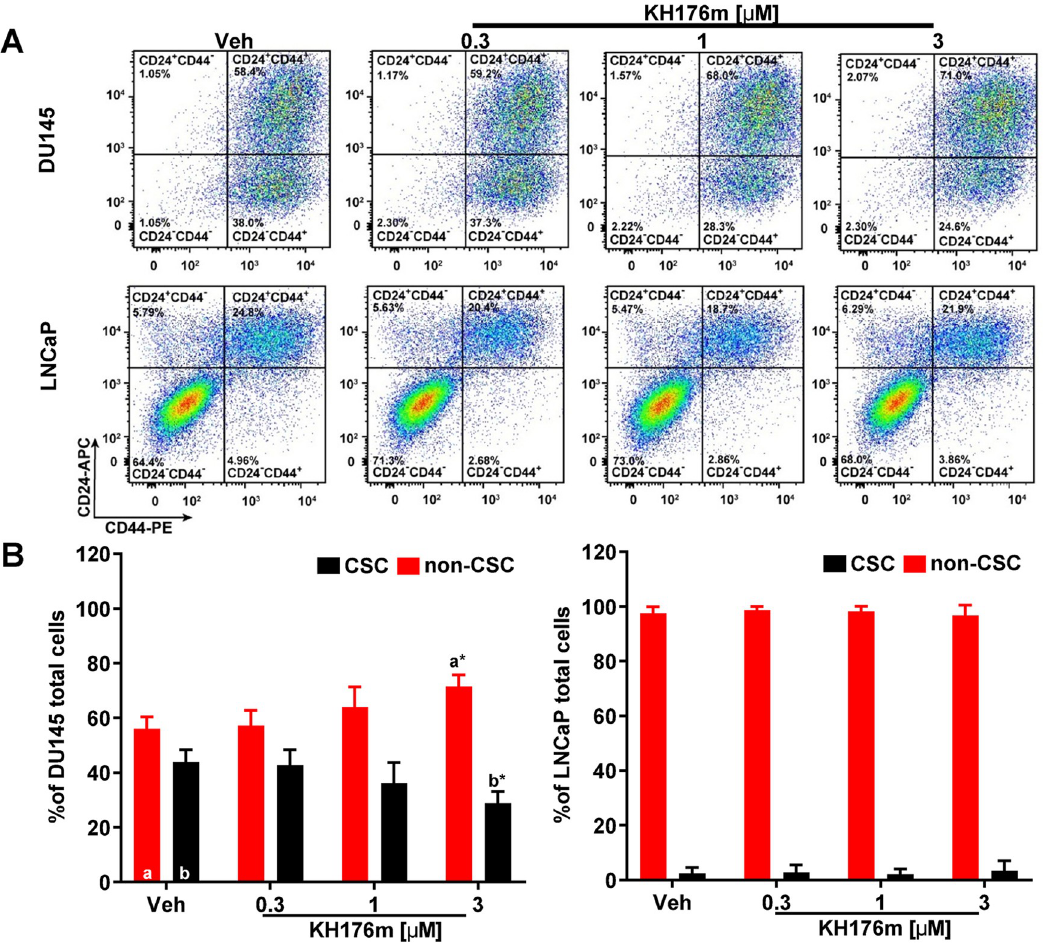
Fig 4. KH176m selectively decreases prostate cancer stem cell population. DU145 and LNCaP human prostate cancer cells were grown in Matrigel to induce spheroid formation and treated with vehicle (0.1% DMSO) or various concentrations of KH176m for